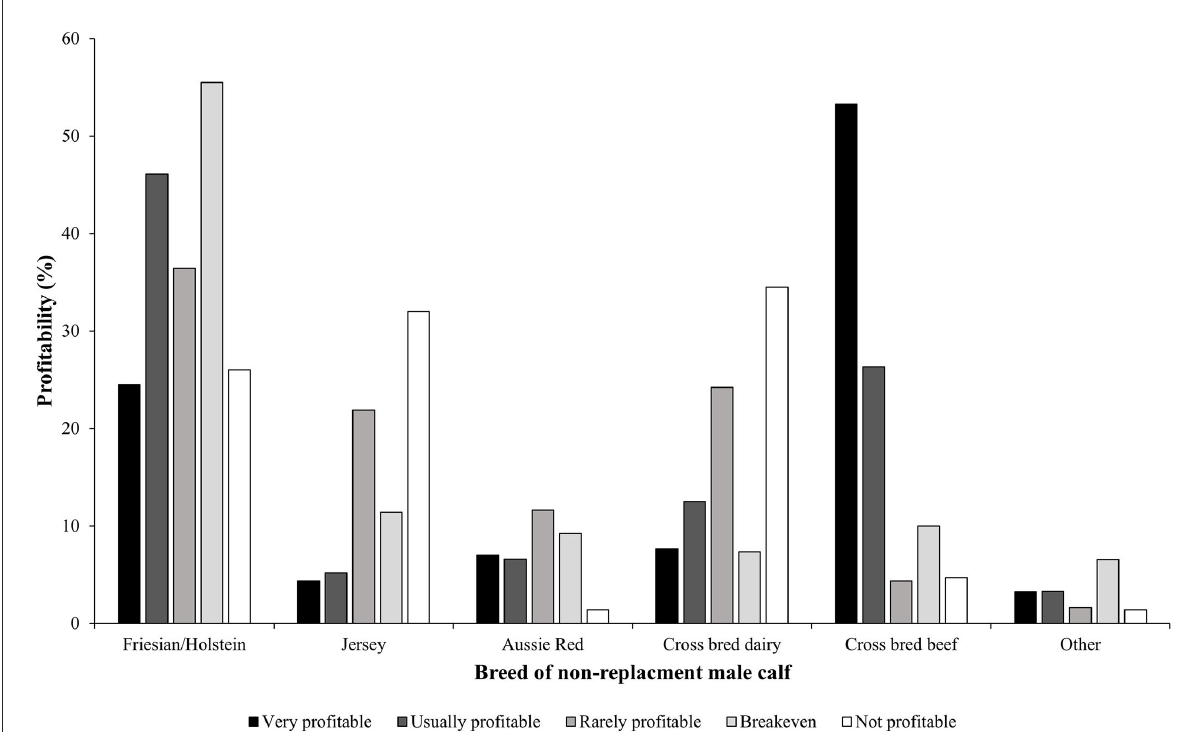
FIGURE4 Profitability of breeds of non-replacement male calves reported by Australian dairy producers in 2021 (probabilities reported from the Bayesian model). The color gradient is represented by the following profitability categories from darkest to lightest; very profitable, usually profitable, rarely profitable, breakeven, and not